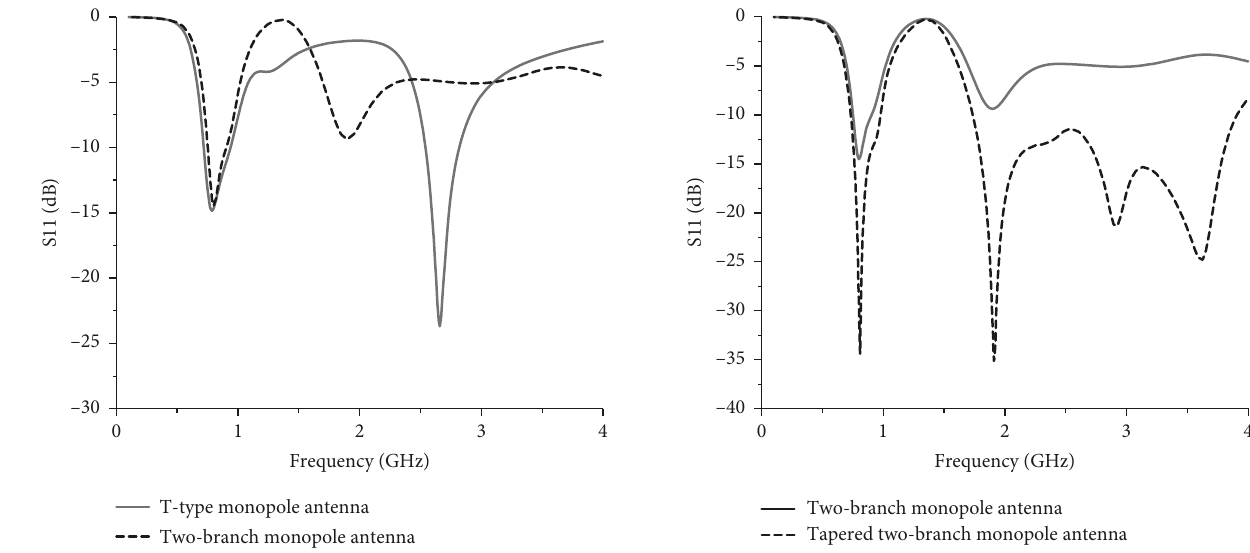
Figure 3: Comparison of a T-shaped monopole antenna and two- branch monopole antenna.